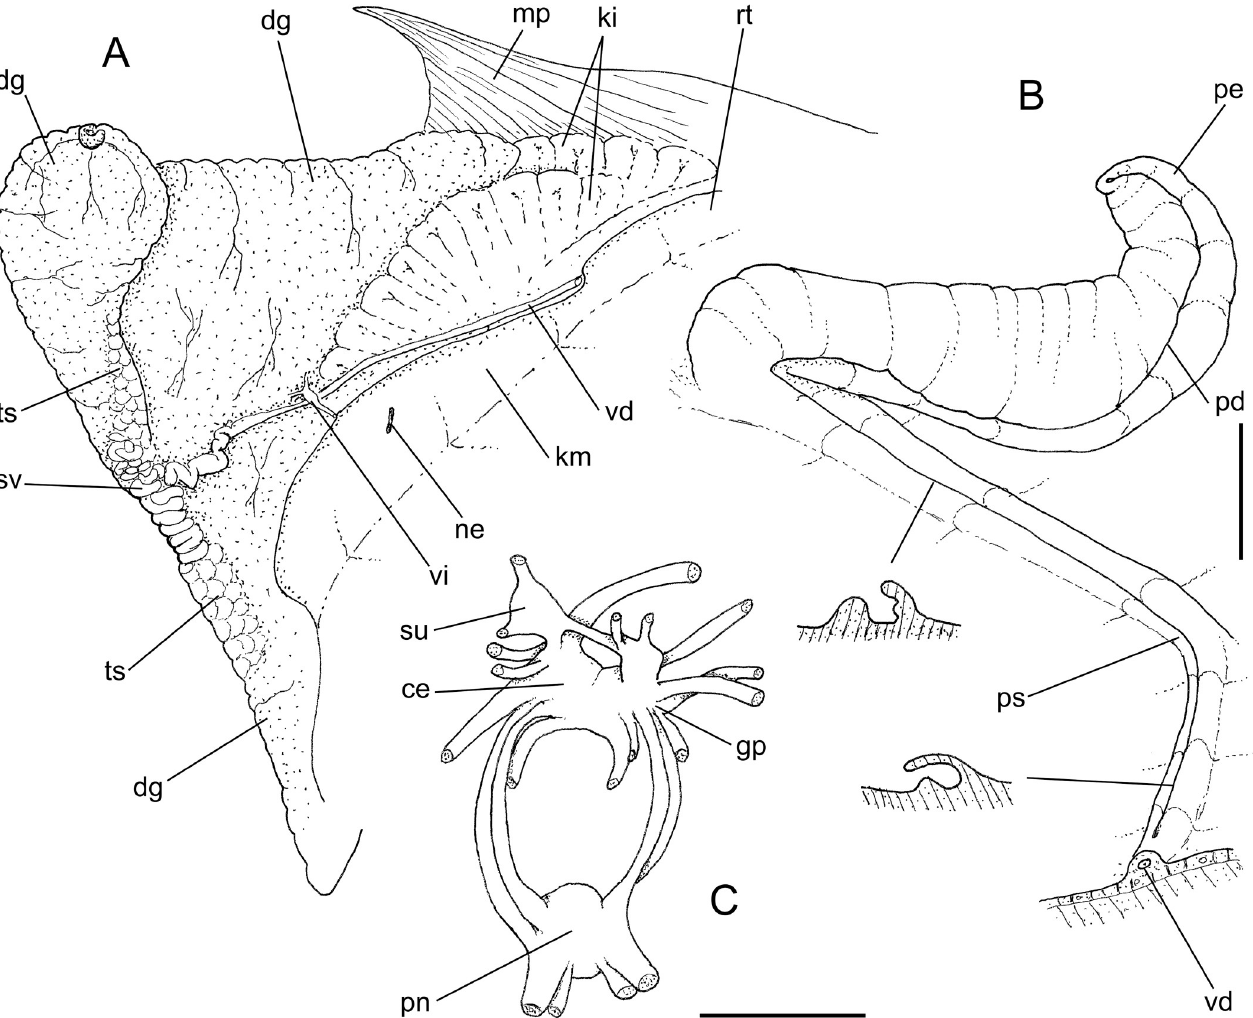
Fig 10. Macrocypraea cervus anatomy. (A) Visceral mass, male, ventral view, partially uncoiled. (B) Right region of pallial cavity floor and penis, dorsal- slightly posterior view, transverse section in two indicated regions also shown. (C) Central nervous system, ventral view. Scales = 5 mm.